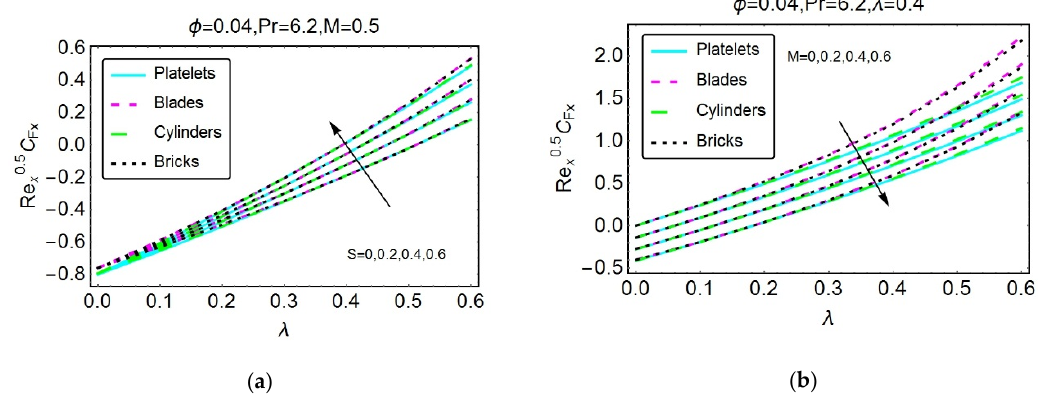
Figure 8. The variations in the skin friction coefficient in the y ‐ direction for different values of ( a ) S and ( b ) M.